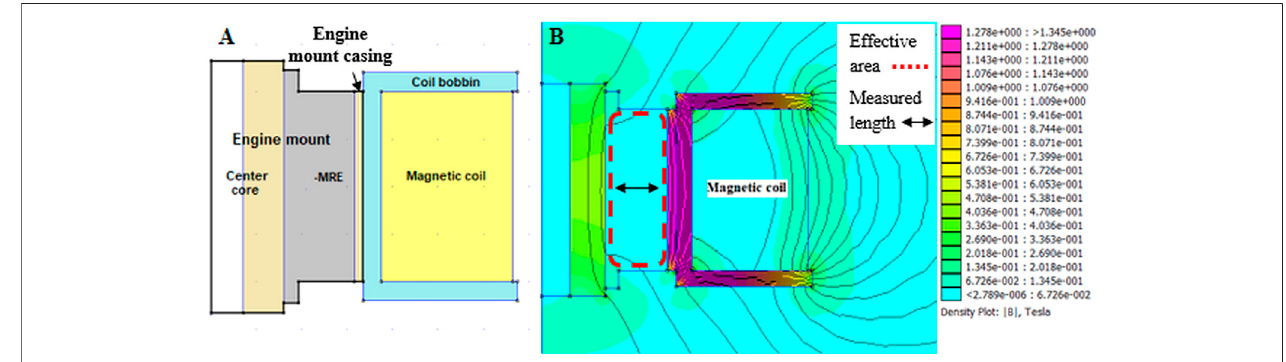
FIGURE 4 | (A) 2D axisymmetric planar diagram of the engine mount with an external coil; (B) Distribution of the magnetic fi eld throughout the device.